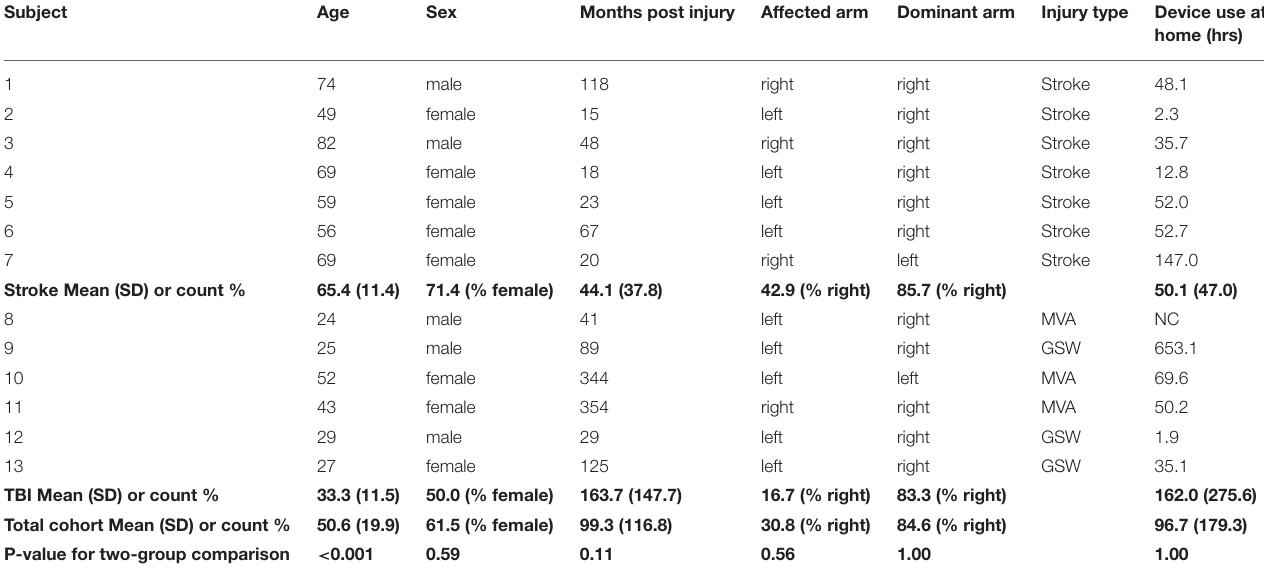
TABLE 1 | Participant characteristics and device use at